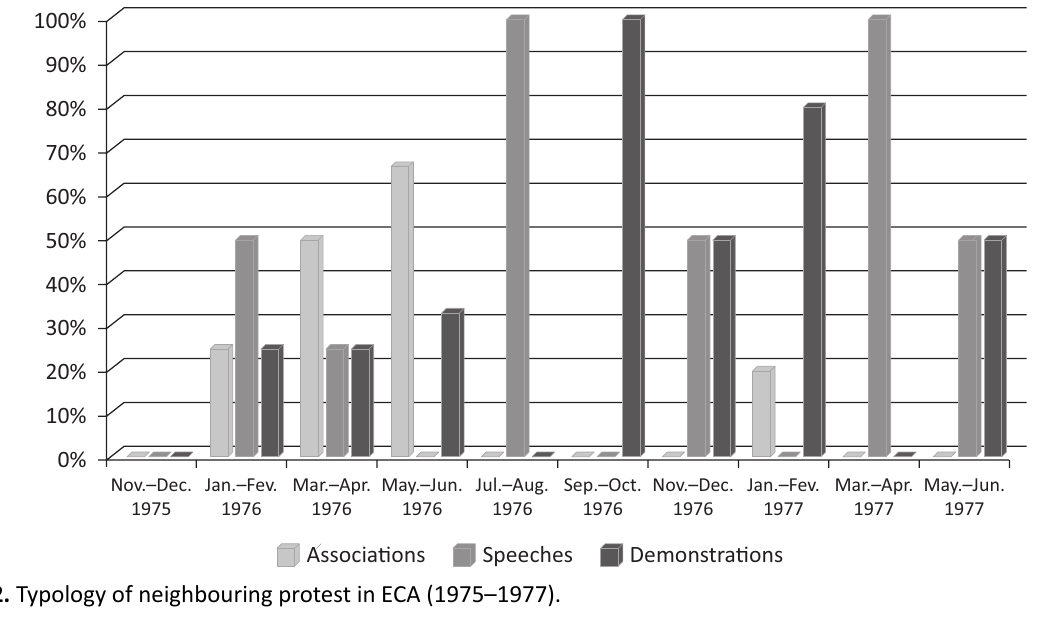
Figure 2. Typology of neighbouring protest in ECA (1975–1977). lights holding numerous placards with different slogans, including the white and green Andalusian flags, one of which heads the demonstration with the label “The San Jerónimo association requires traffic lights” and that the episode “develops in the most complete normality”. In October, the newspaper echoes the acts of protest in the street as expressed by the demonstrations of the Palmete residents in which they ask for a solution to their eternal water and sewer problem. Additionally, the unfulfilled promises of the mayor that are recurring at the end of the year stand out: “Approximately 1,500 people demonstrated in Palmete” (ECA, 1976n, p. 39), “Palmete’s residents cut the traffic on the Su Eminen- cia road again” (ECA, 1976o, p. 17) or “Palmete’s neigh- bours cut the traffic in Su Eminencia for an hour” (ECA, 1976p, p.